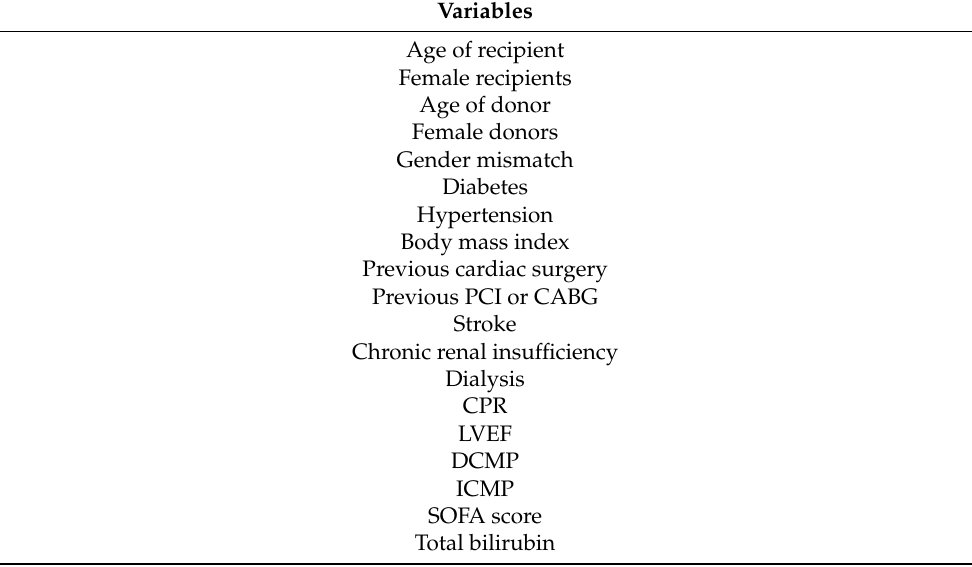
Table A1. Variables for